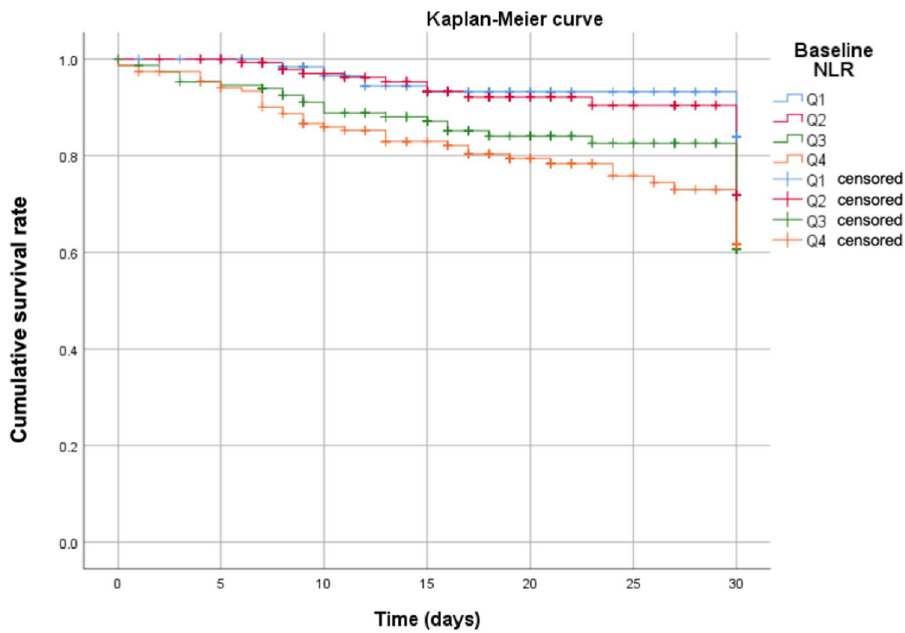
Figure 2. Kaplan–Meier curves for 30-day in-hospital survival among quartiles of baseline NLR. Cumulative probabilities of survival with increasing NLR values were shown. Q1–Q4 correspond to quartiles of the baseline